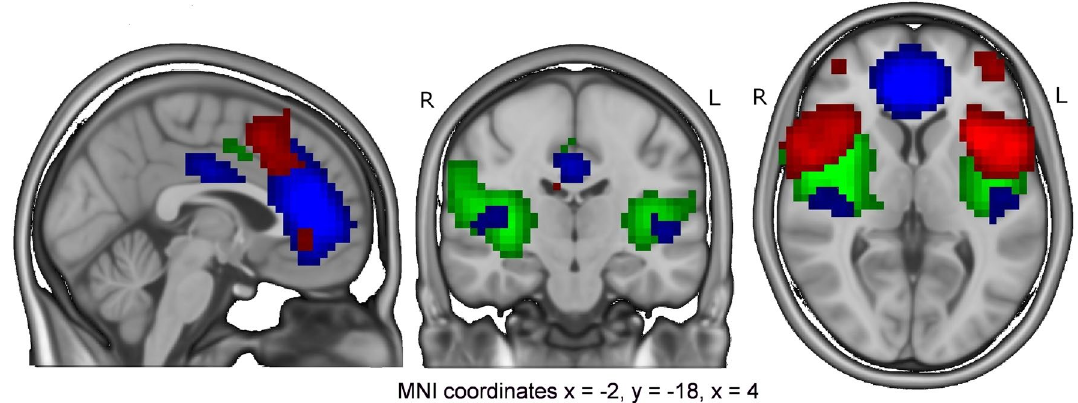
Figure 1. Regions of the selected independent components (green = IC4, blue = IC15, red = IC27).